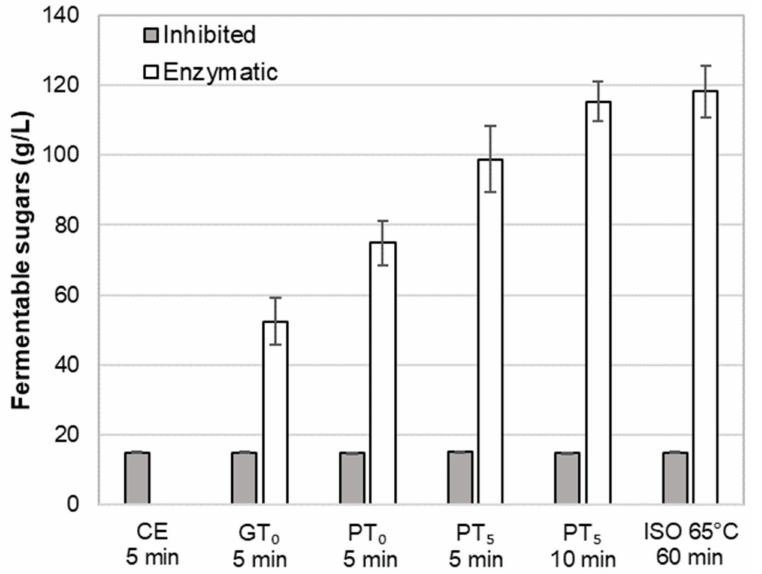
Figure 6. Impact of mashing at characteristics temperature levels for different durations at inhibited or enzymatic conditions on the average amount of fermentable sugars. Data points refer to mean values ( N = 18) and error bars represent the standard